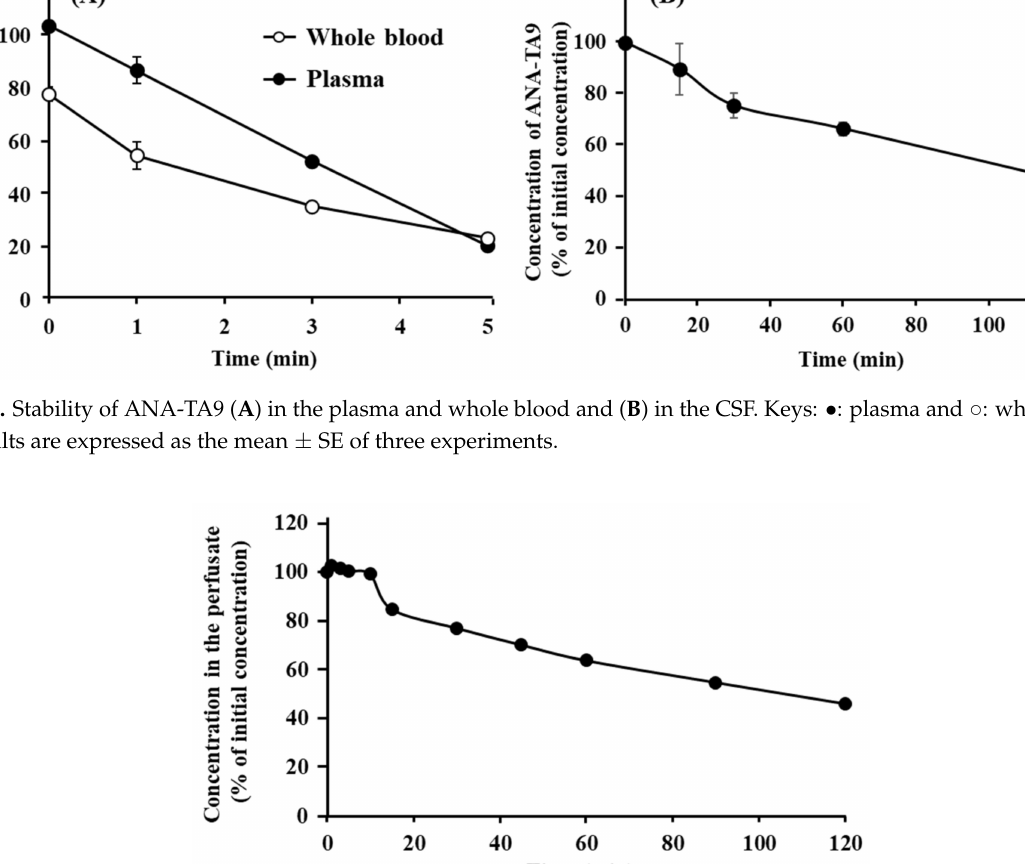
Figure 4. Degradation of ANA-TA9 on the surfaces of nasal epithelial cells. The results are expressed